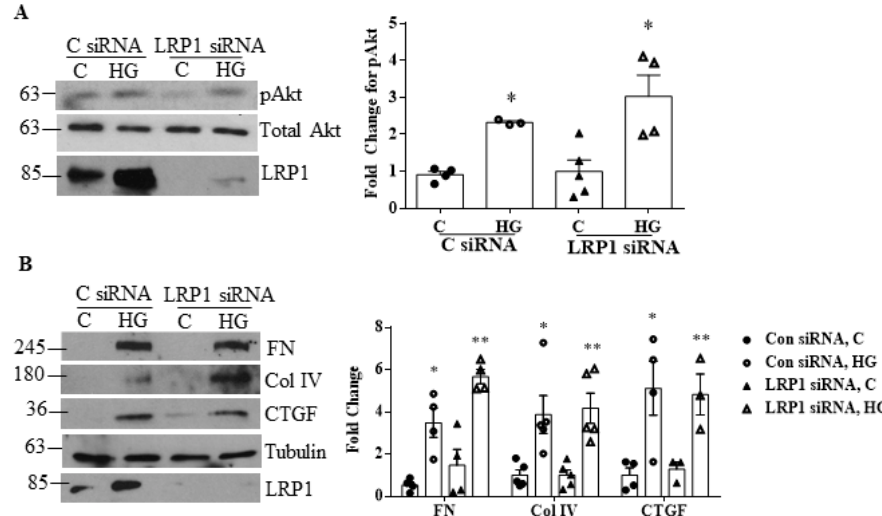
Figure 5. LRP1 knockdown did not affect Akt activation or ECM production. ( A , B ) Knockdown of LRP1 with siRNA did not attenuate Akt activation (pAkt on S473) or production of fibronectin (FN), Collagen (Col) IV, or CTGF compared to control siRNA in response to high glucose (HG, 48 h). Successful LRP1 knockdown is shown ( n = 5, * p < 0.01 or ** p < 0.05 vs. all others in individual group).